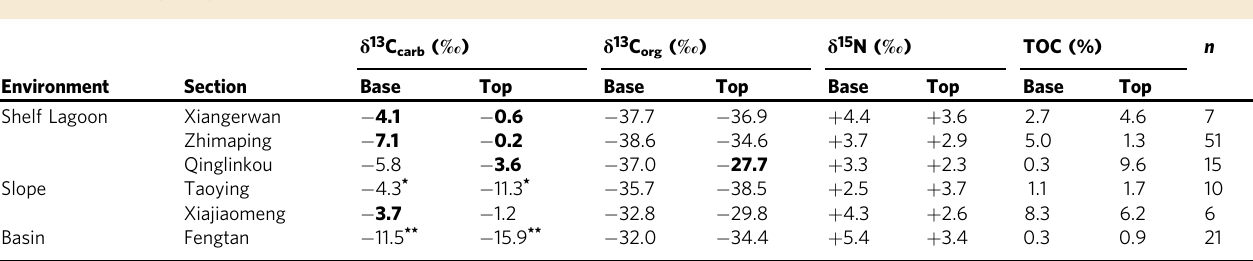
Data show end-member values of Member IV (base and top). In sections where data at the base and top of Member IV were not available, data from the Member III-Member IV and Member IV- DengyingFm.boundarieswereused andareexpressedinbold.(*)representsdatafromananalogousupperslopeenvironmentsection(Siduping 30 ).(**)representsdatafromtheFengtansection 28 . n = number of samples.